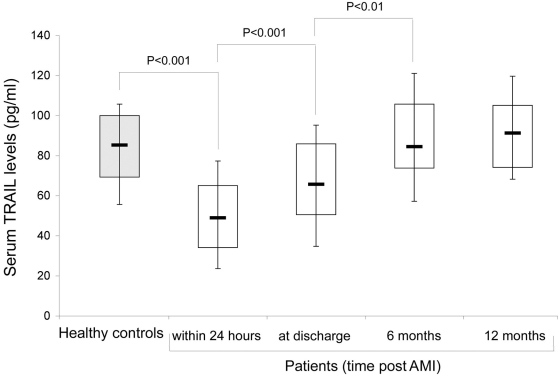
Serum TRAIL levels in AMI patients and healthy individuals.Levels of TRAIL were determined by ELISA in sera from AMI patients (analyzed at the indicated times post AMI) and from healthy control subjects. Horizontal bars are median, upper and lower edges of box are 75th and 25th percentiles, lines extending from box are 10th and 90th percentiles.